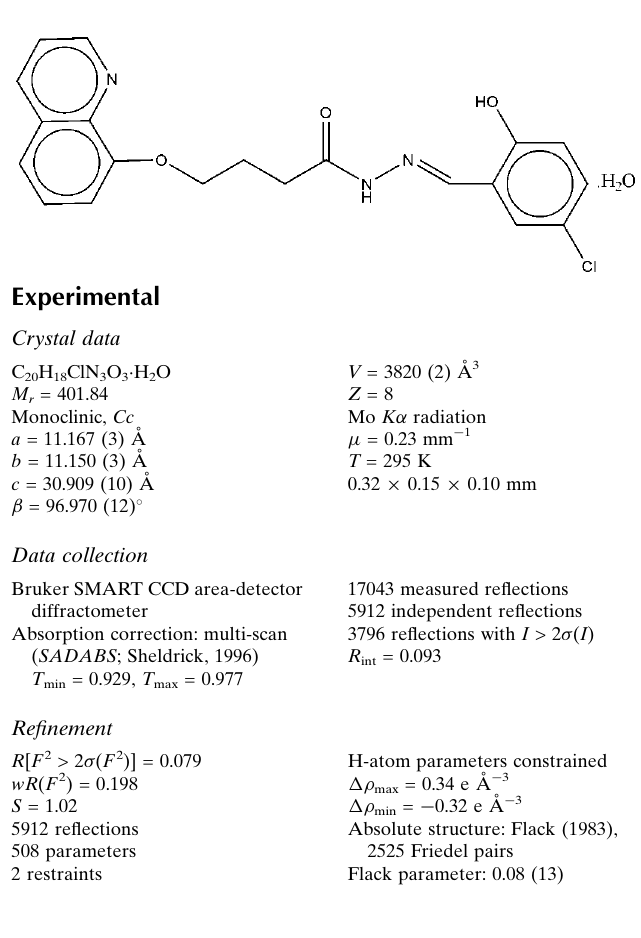
17043 measured reflections 5912 independent reflections